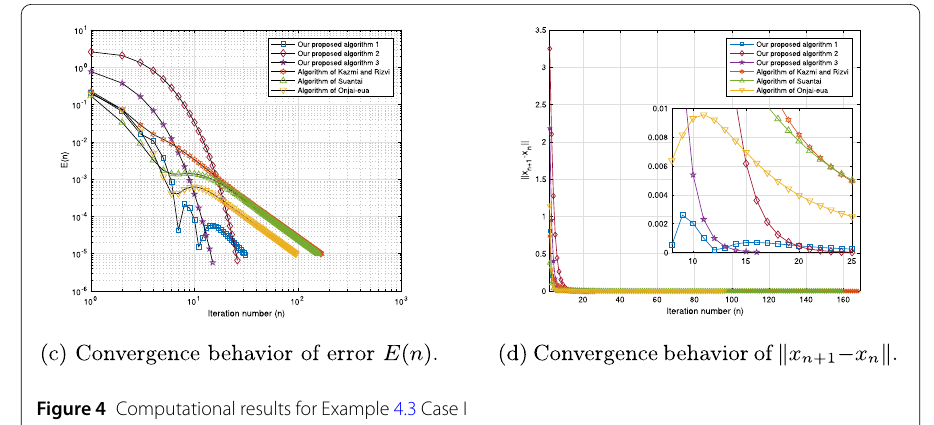
Figure 4 Computational results for Example 4.3 Case I